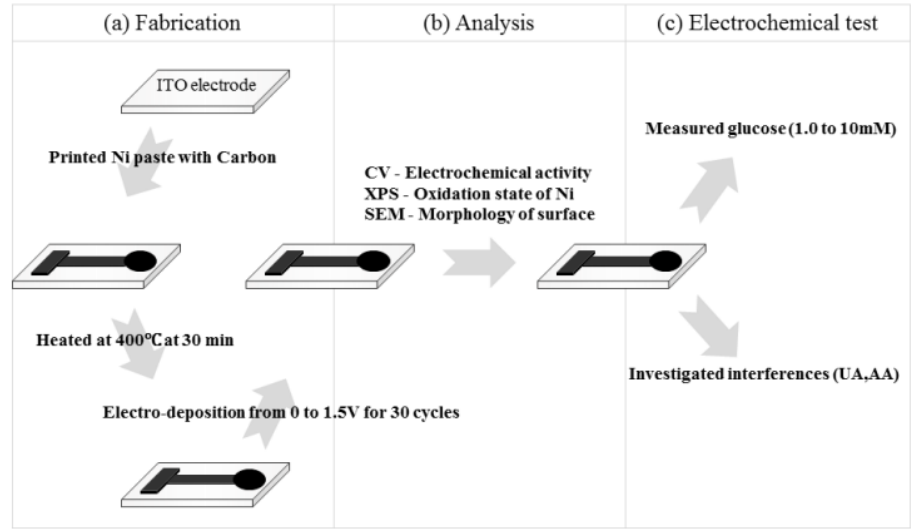
Figure 7. Schematic illustration of the ( a ) fabricating of Ni(OH) 2 /NiOOH-DSPNCE; ( b ) analysis of Ni(OH) 2 /NiOOH-DSPNCE; and ( c ) the electrochemical test. Reprinted from Ref. [59].